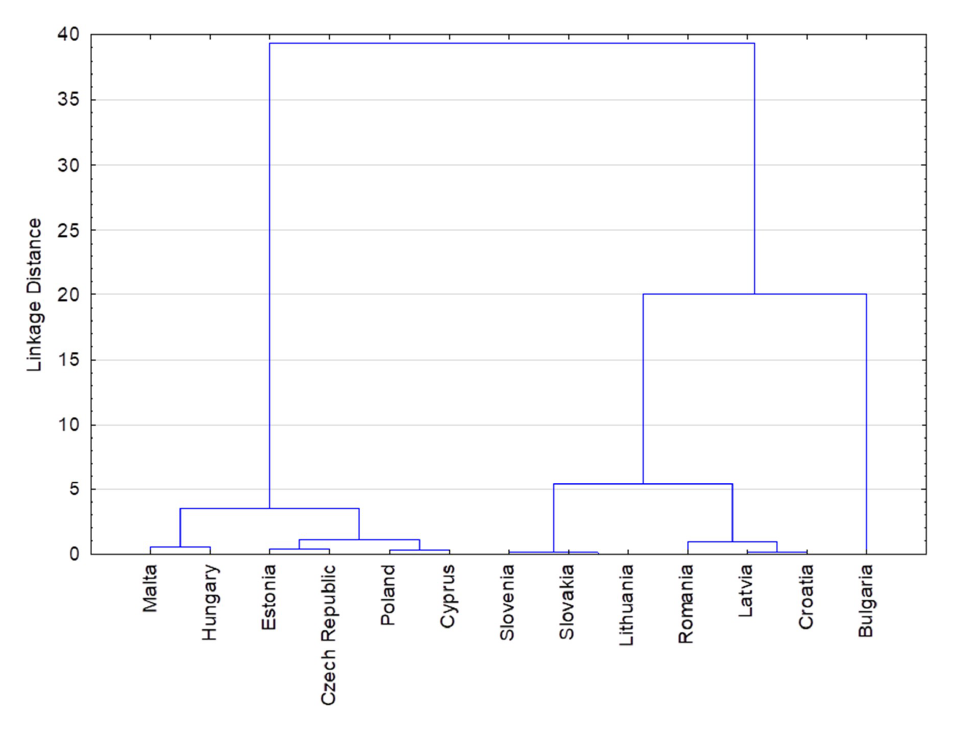
Figure 8. Tree diagram for IRE in 2016.